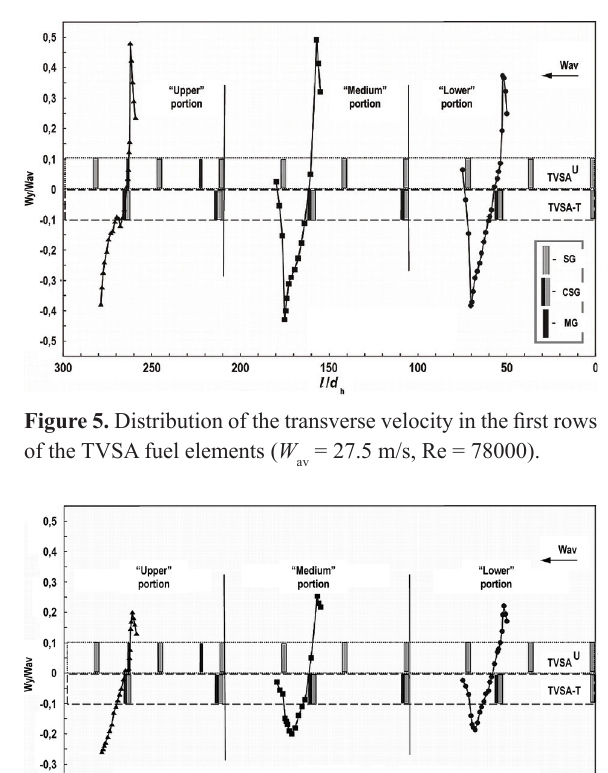
Figure 6. Distribution of the transverse velocity in the second rows of the TVSA fuel elements ( W